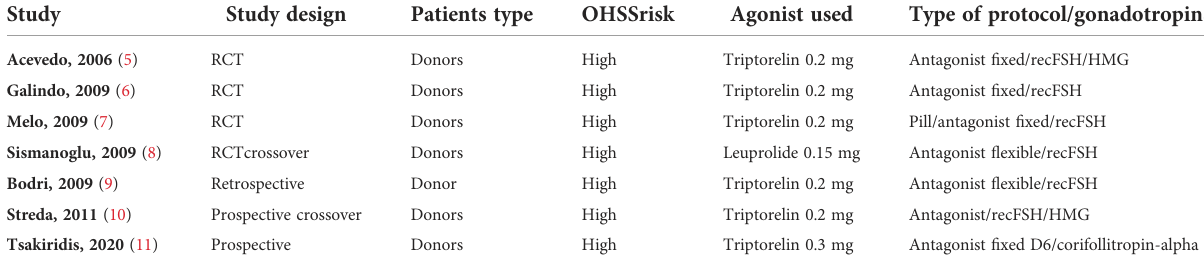
TABLE 1 Special characteristics of the included